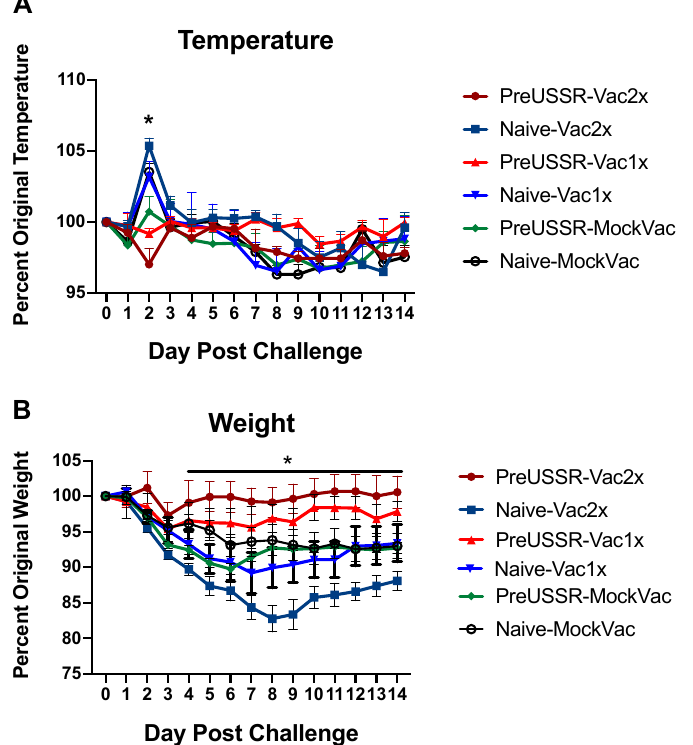
Figure 2. Previous imprinting with a historical H1N1 influenza virus increases influenza vaccine protection. Ferrets were infected with the historical H1N1 virus USSR / 77 (10 6 EID 50 ) to establish an influenza-specific immune background or were left naïve. After 67 and 105 days, the vaccine group were vaccinated with the Sanofi FLUZONE ® QIV vaccine. All groups were challenged at Day 123 with the contemporary Cal / 07 H1N1 pandemic 2009 virus. ( A ) Temperature and ( B ) weight changes were monitored for 14 days p c. * indicates a p -value of less than 0.05.